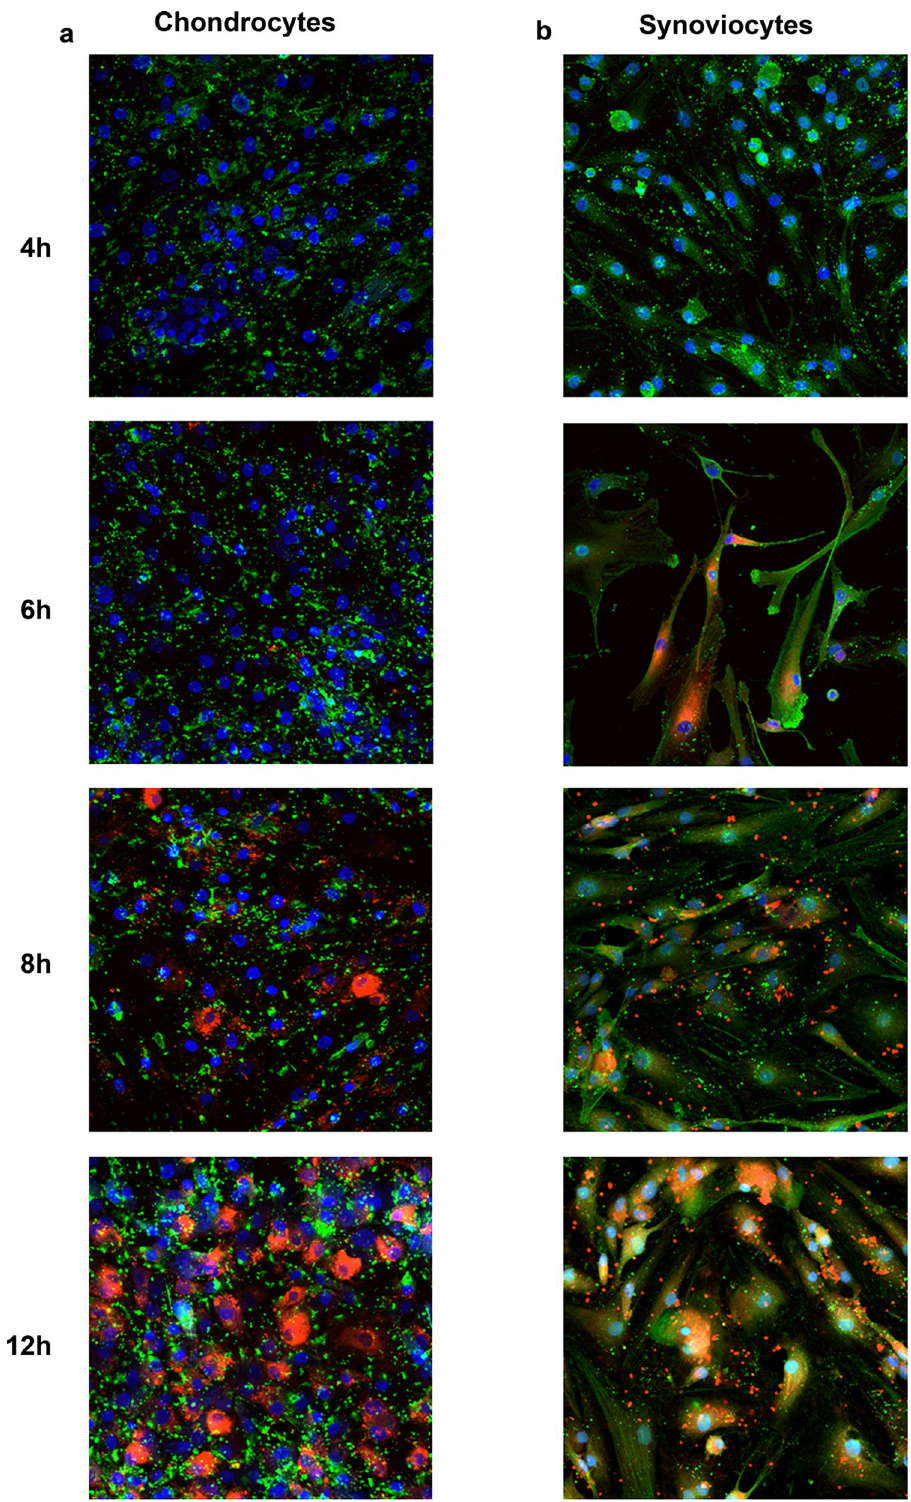
Figure 2. Cellular uptake assay at 4, 6, 8, and 12 h on chondrocytes ( a ) and synoviocytes ( b ). Merged images of PKH26-labelled sEV (red), cytoskeleton (green) and nuclei (blue) staining revealed the localization of sEV in the cytoplasm and around nuclei. ( a ) Chondrocyte and ( b ) synoviocyte representative images obtained with a NIKON A1-R confocal laser scanning microscope equipped with PlanApo VC 20 × Air 0.75NA objective